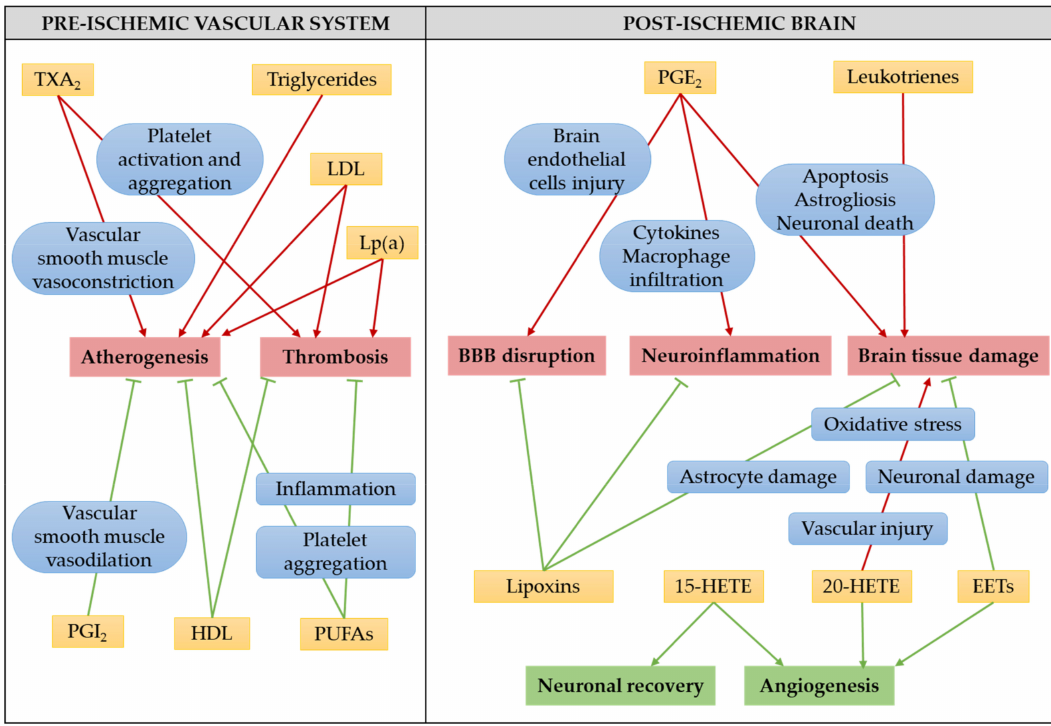
Figure 3. Possible mechanisms of involvement of serum lipids and eicosanoids in the pathophysiology of ischemic stroke. Arrows indicate stimulation, while bar-headed lines indicate inhibition. Green color stands for beneficial, while red for detrimental e ff